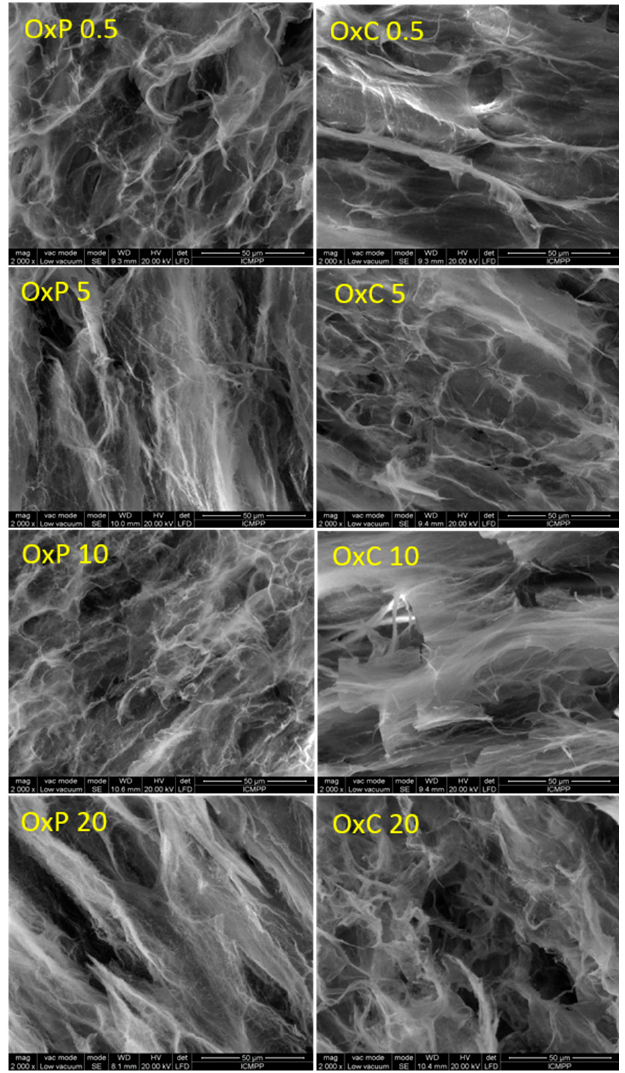
Figure 3. SEM microphotographs (2000× magnification) of cross-sections of PVA hydrogels containing 0.5%, 5%, 10% and 20% oxidized pullulan (OxP 0.5, OxP 5, OxP 10, OxP 20) and tricarboxy cellulose (OxC 0.5, OxC 5, OxC 10, OxC 20), respectively.